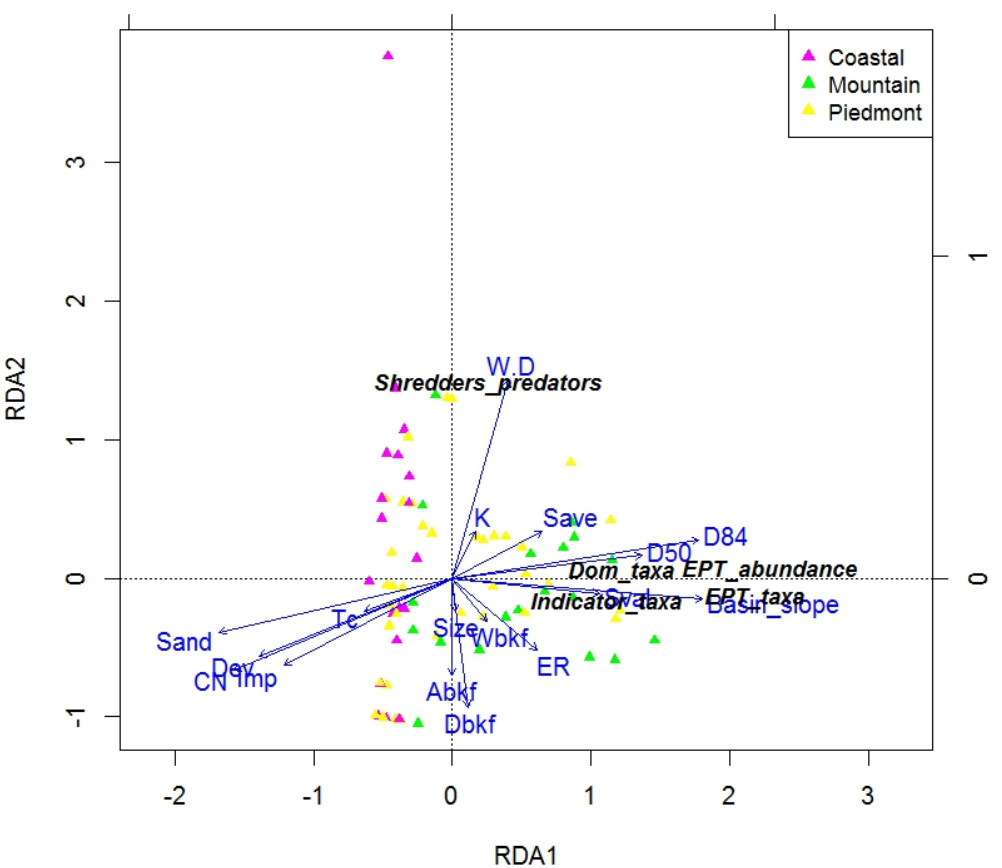
Figure 2. Redundancy Analysis (RDA) triplot showing results of ordination combined with regression of 11 morphology and six watershed variables to five macroinvertebrate metrics at 79 streams.